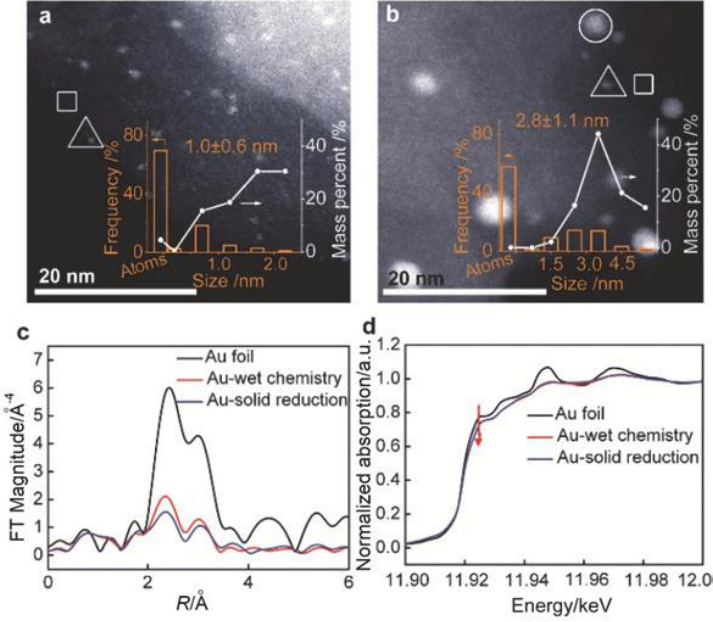
Figure 20. Aberration-corrected HAADF-STEM images of Au/SiO 2 -Schiff prepared by ( a ) solid reduction method and ( b ) wet chemistry method, respectively. The NPs, subnanoclusters, and isolated Au atoms were indicated by white circles, triangles, and squares, respectively. ( c ) Fourier transform of k 3 -weighted EXAFS spectra and ( d ) normalized Au L 3 -edge XANES spectra of Au/SiO 2 -Schiff catalysts prepared by wet chemistry and solid reduction method, respectively. Reprinted from Ref. [130]. Copyright 2018 with permission of Wiley.